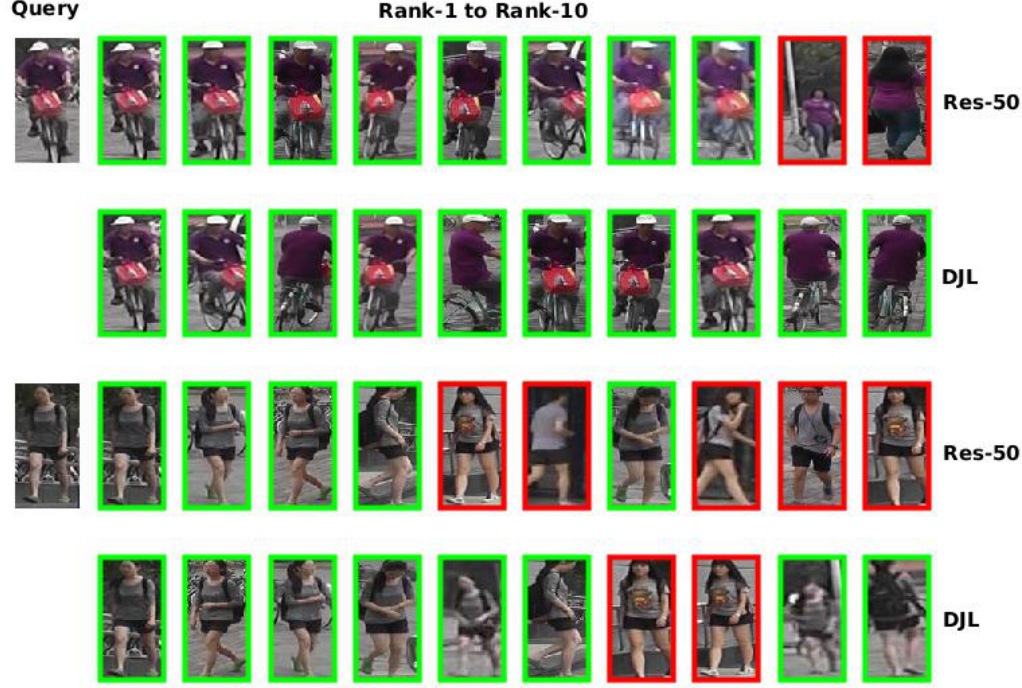
Figure 8. Example person re-ID results by using the base Residual-50 network (Res-50) and the proposed DJL network on Market-1501 database. Correct retrievals are surrounded with green bounding boxes while wrong retrievals are surrounded with red bounding